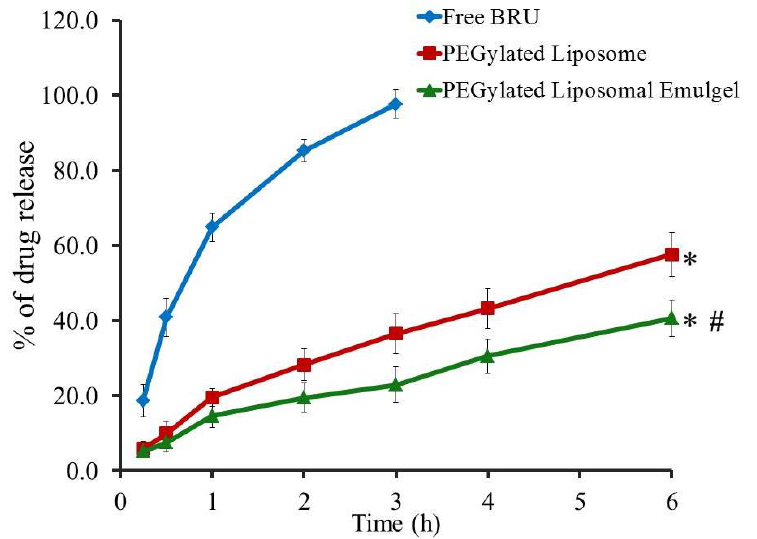
Figure 8. In vitro release outline of Brucine from free Brucine suspension, PEGylated liposome and PEGylated liposomal emulgel in phosphate buffer pH 7.4 at 37 °C. Results are identified with respect to the mean ± SD of three experiments. * p < 0.05 compared to free drug; # p < 0.05 compared to PEGylated liposome formulation.